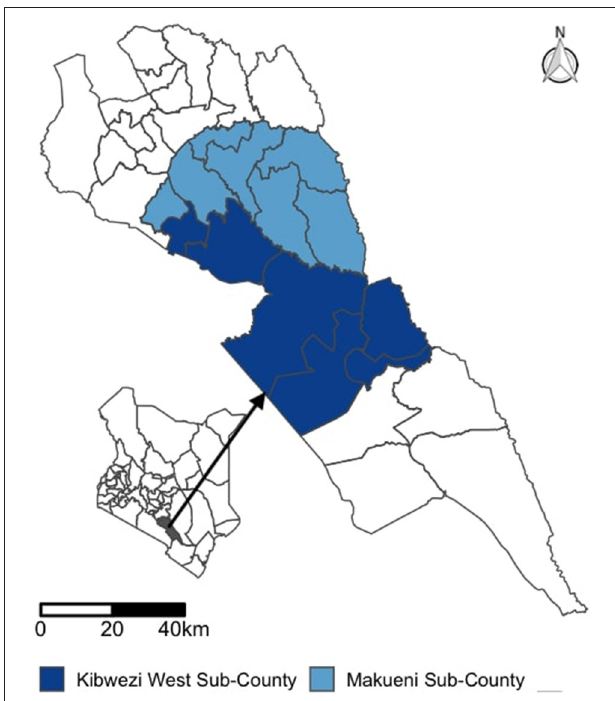
FIGURE 1 | Map showing the study area comprising of sub-Counties in the South Eastern Kenya in the County of